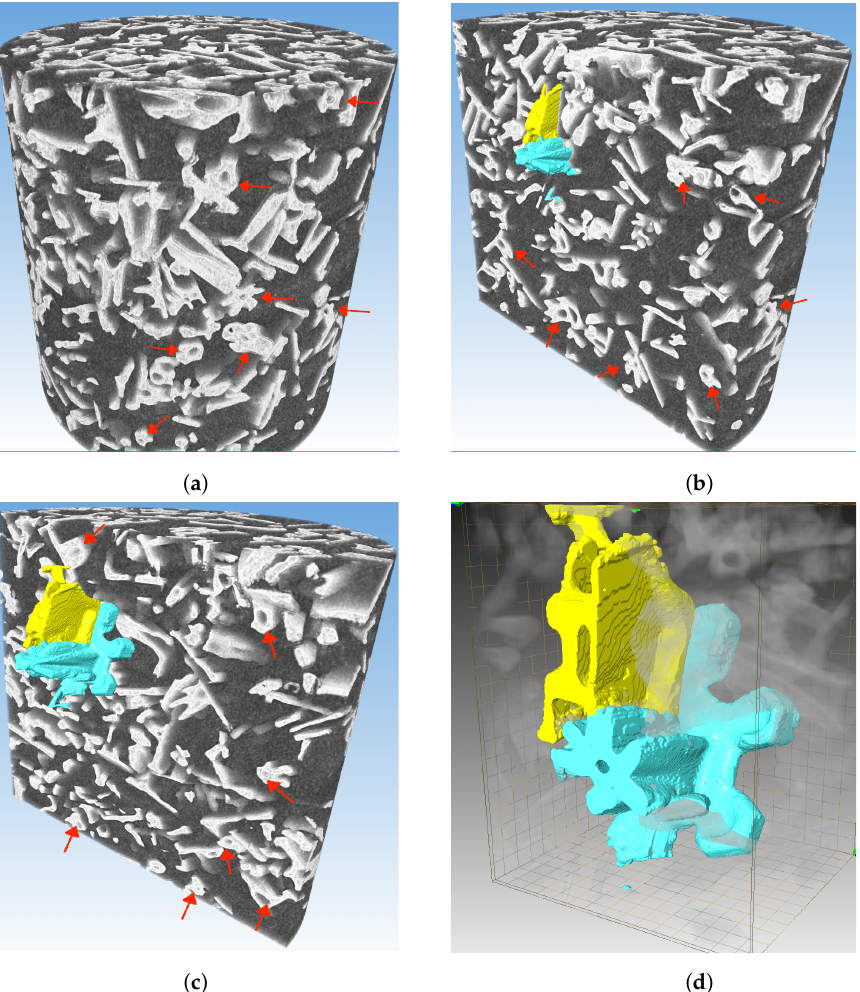
Figure 4. 3D images of snow grains distribution: ( a ) scan of the whole investigated snow volume; ( b ) scan of the snow volume across a cross-section and selection of two individual grains; ( c ) slightly deeper cross-section than the one shown in Figure 4b, to focus on the individual grains; ( d ) structure of two individual snow grains. Red arrows in Figure 4 represent an example of the described hollow core